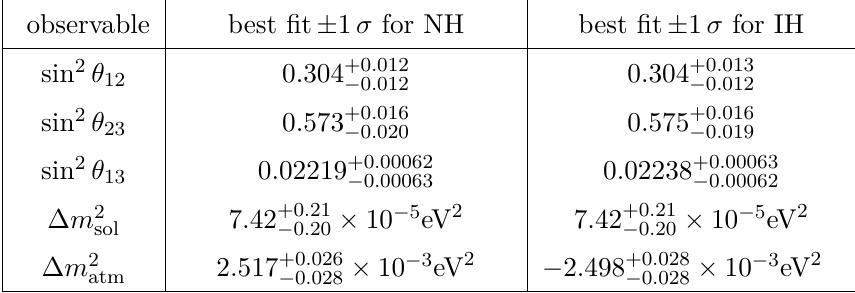
Table 2 . The best fit ± 1 σ of neutrino parameters from NuFIT 5.0 for NH and IH